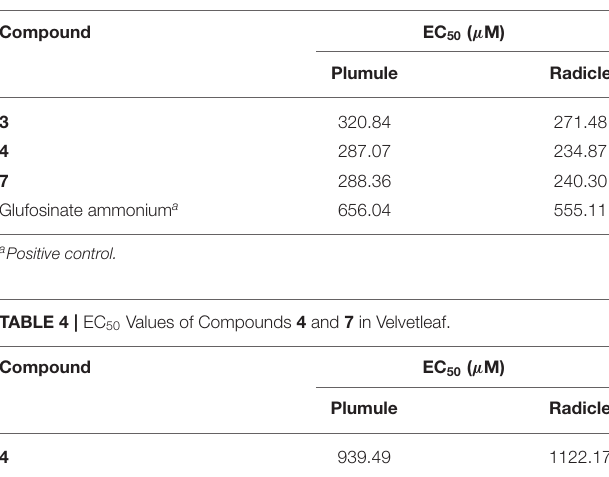
TABLE 3 | EC 50 values of compounds 3 , 4, and 7 in Redroot Amaranth.